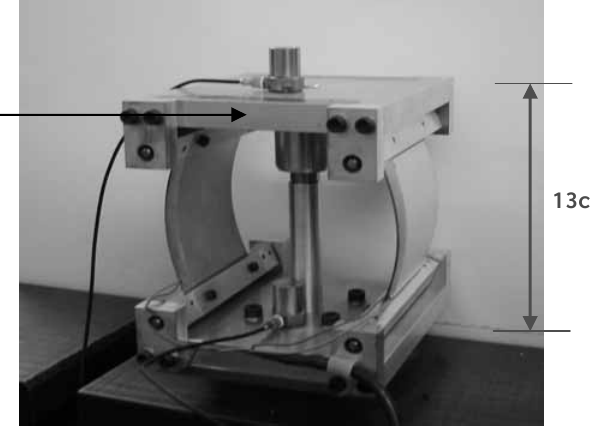
Fig. 5. Prototype ATVA using curved beams as a variable stiffness element.